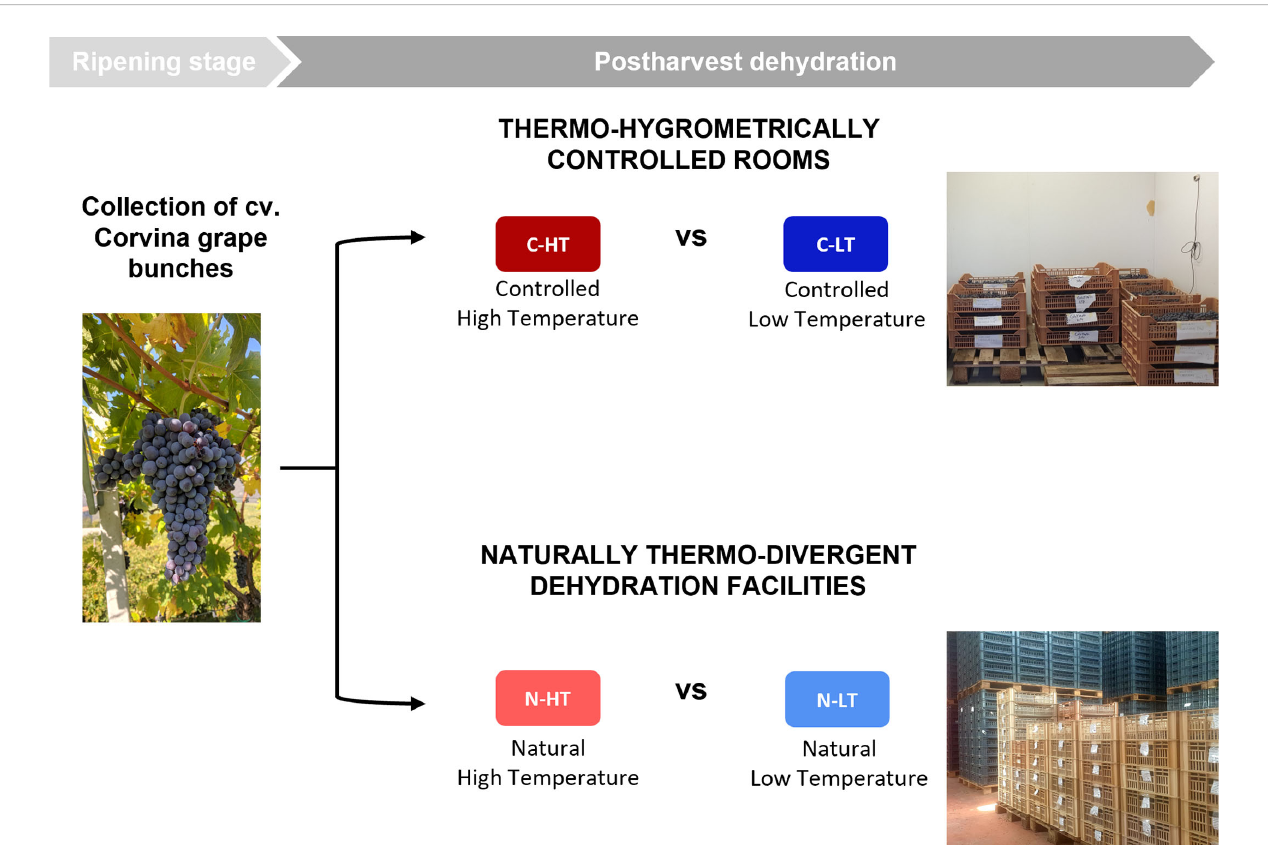
FIGURE 1 Overall experimental work fl ow. Grape bunches of cv. Corvina were collected at ripening stage. To evaluate the temperature effect on postharvest dehydration process, grape withering was conducted under different temperature conditions in two thermo-hygrometrically controlled rooms (C-HT; red vs C-LT; blue) and in two naturally thermo-divergent dehydration facilities (N-HT; light red vs N-LT; light